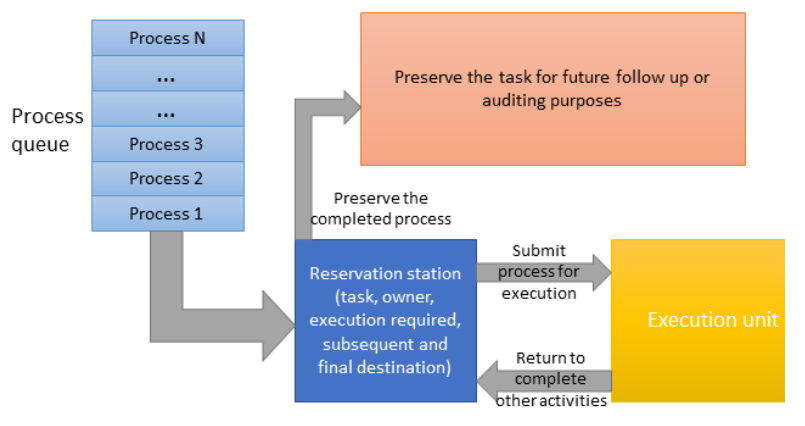
Figure 1. Methodology of the proposed solution.